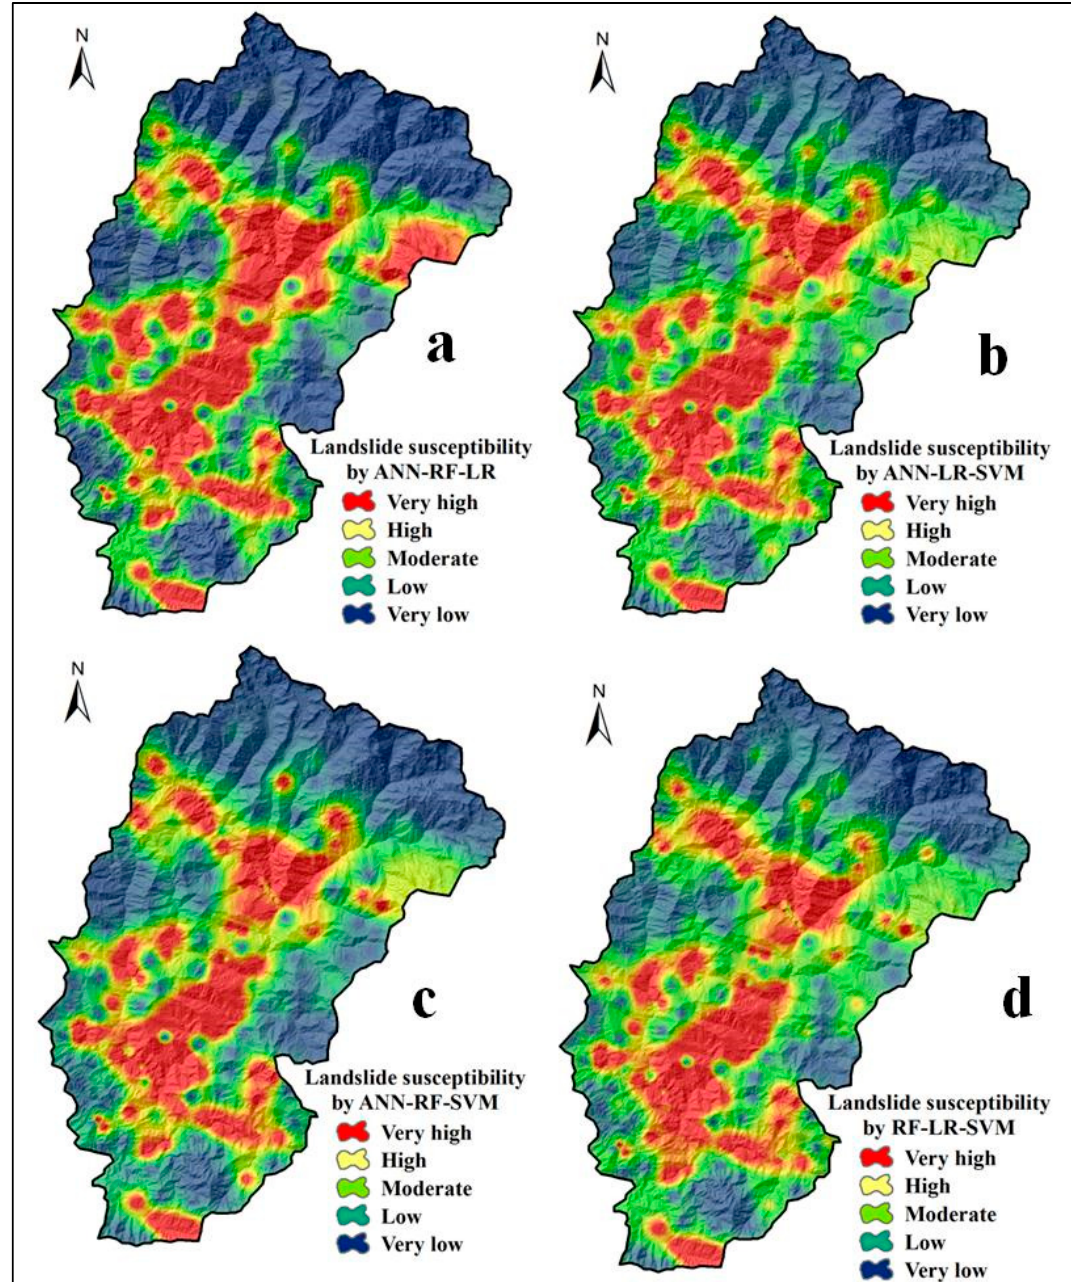
Figure 8. Landslide susceptibility mapping using ensemble of three models: ( a ) ANN-LR-RF, ( b ) ANN-LR-SVM, ( c ) ANN-RF-SVM, and ( d ) RF-SVM-LR.